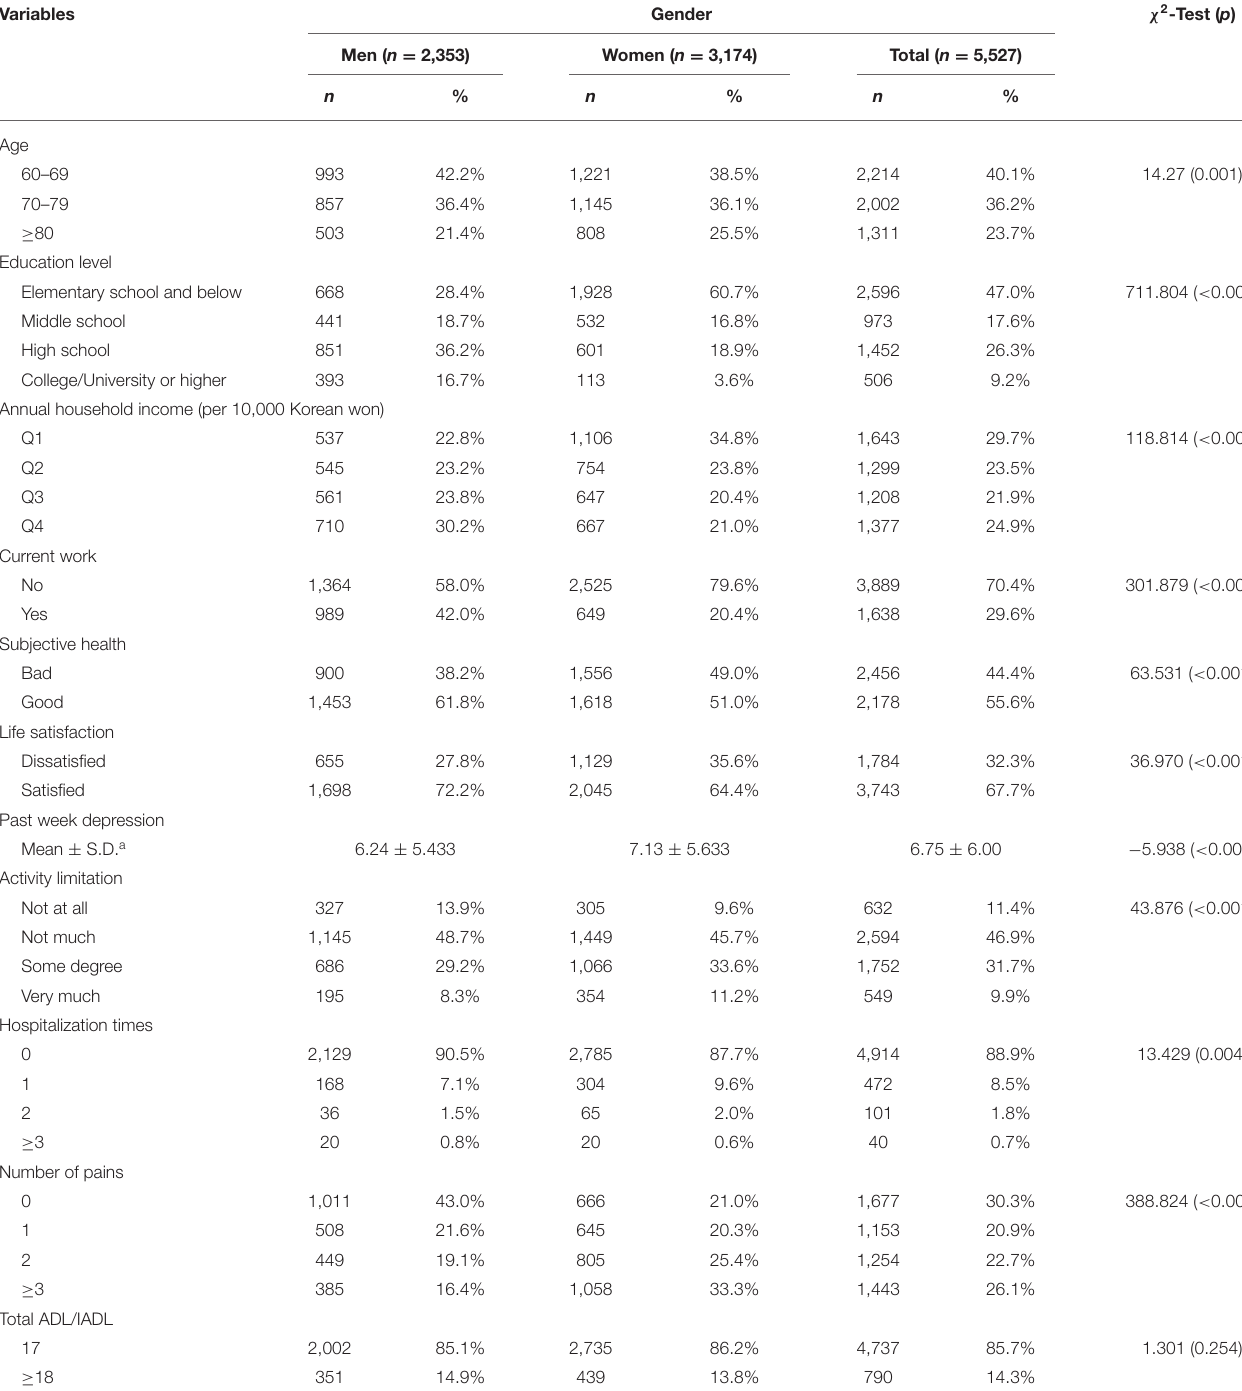
TABLE 2 | Descriptive SES, mental health, and need for LTSS characteristics of participants by gender.